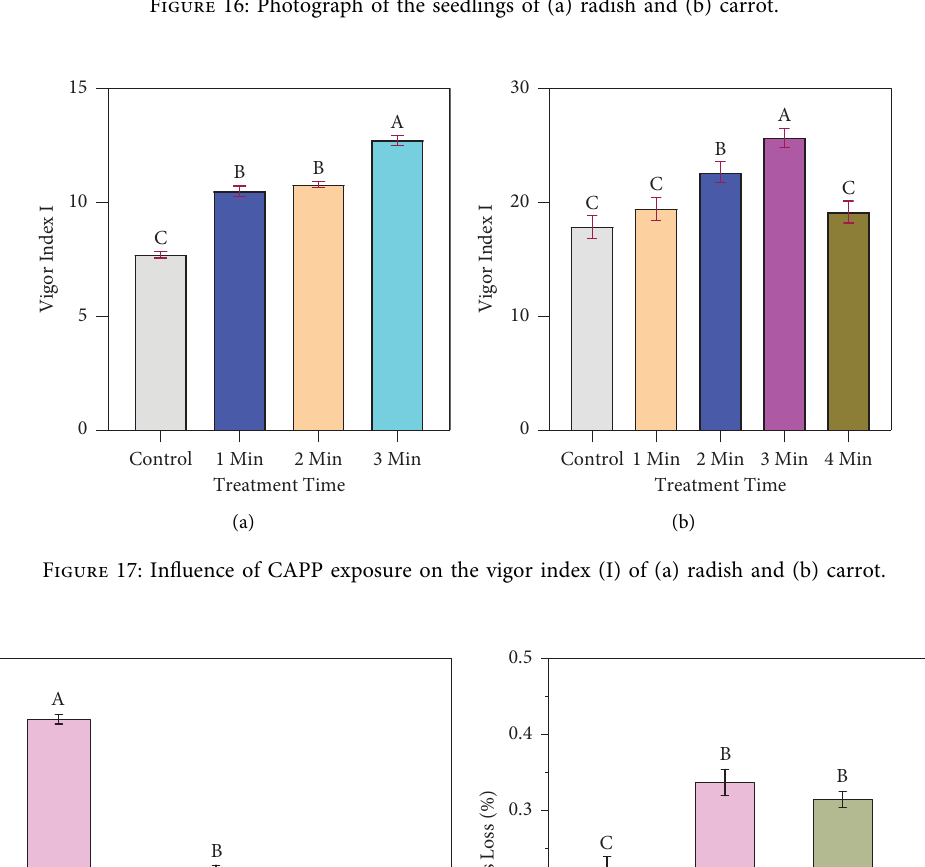
Figure 16: Photograph of the seedlings of (a) radish and (b)